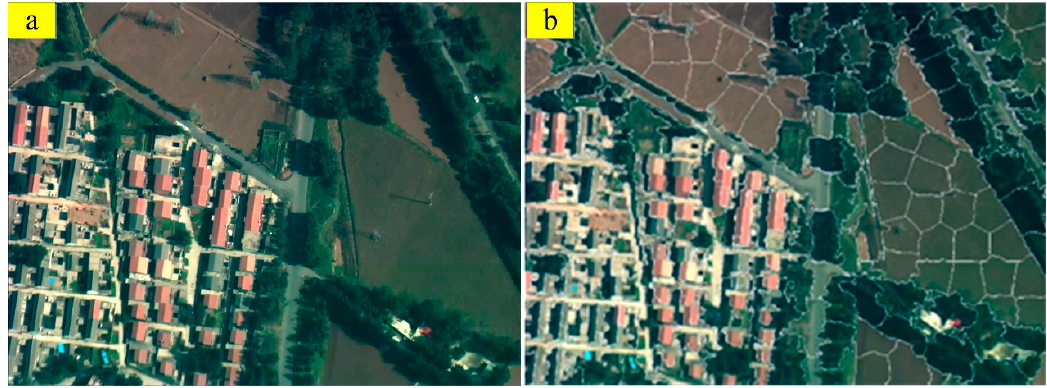
Figure 3. Superpixel segmentation of an aerial image: ( a ) aerial image; and ( b ) result of superpixel region segmentation of ( a ).